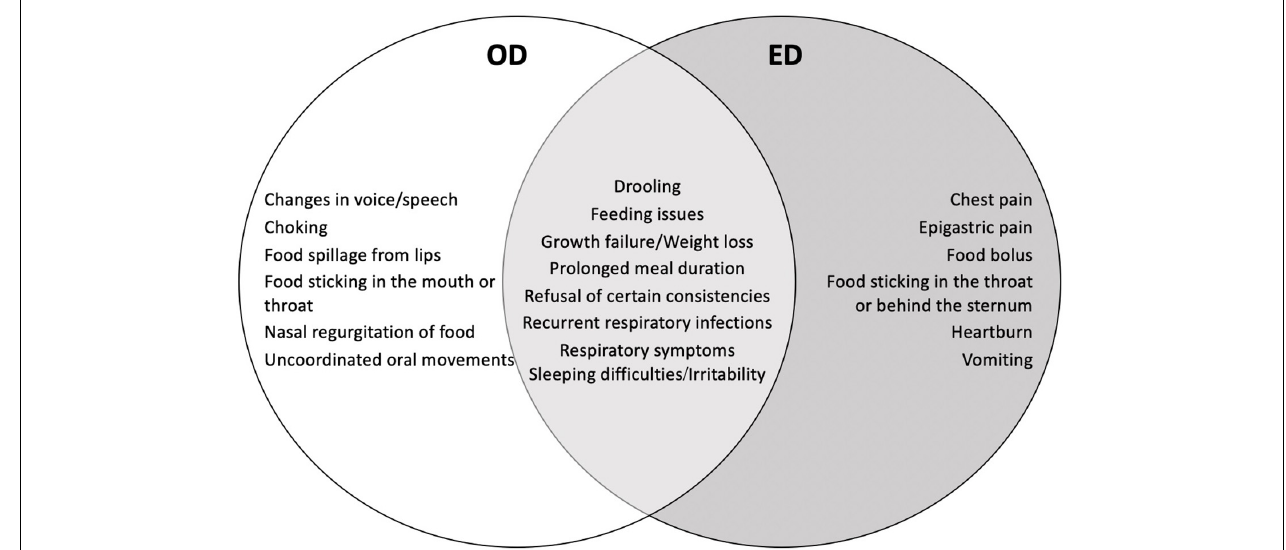
FIGURE 1 | Common and peculiar clinical features of oropharyngeal and esophageal dysphagia (71, 72).